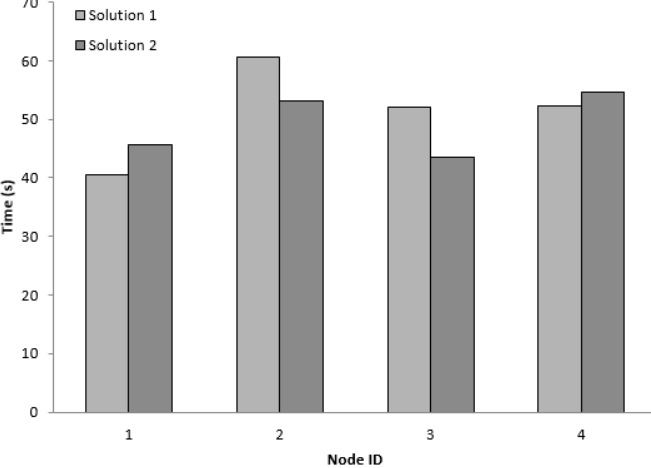
Figure 8. MEDLINE data, four nodes, homogeneous environment.